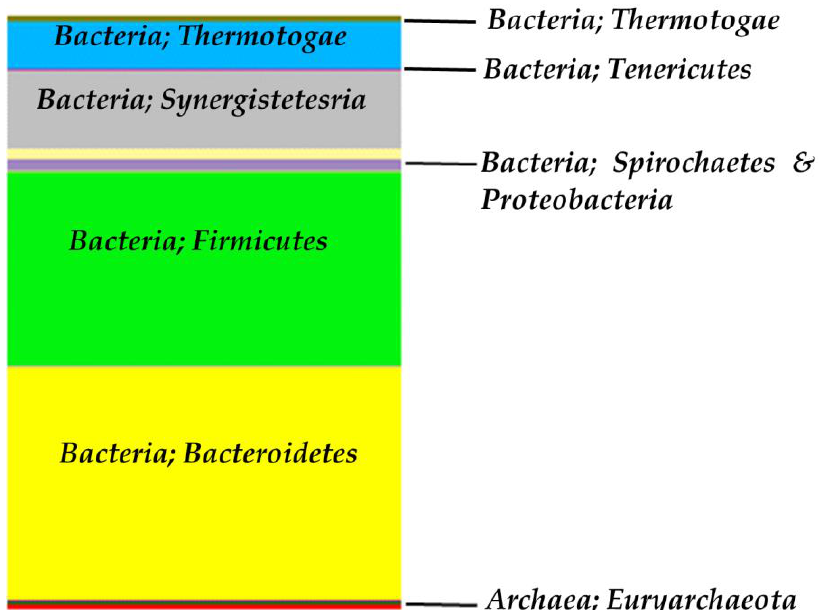
Figure 9. Biodiversity in the two-stage reactor in the anaerobic digestion system (the main phyla).